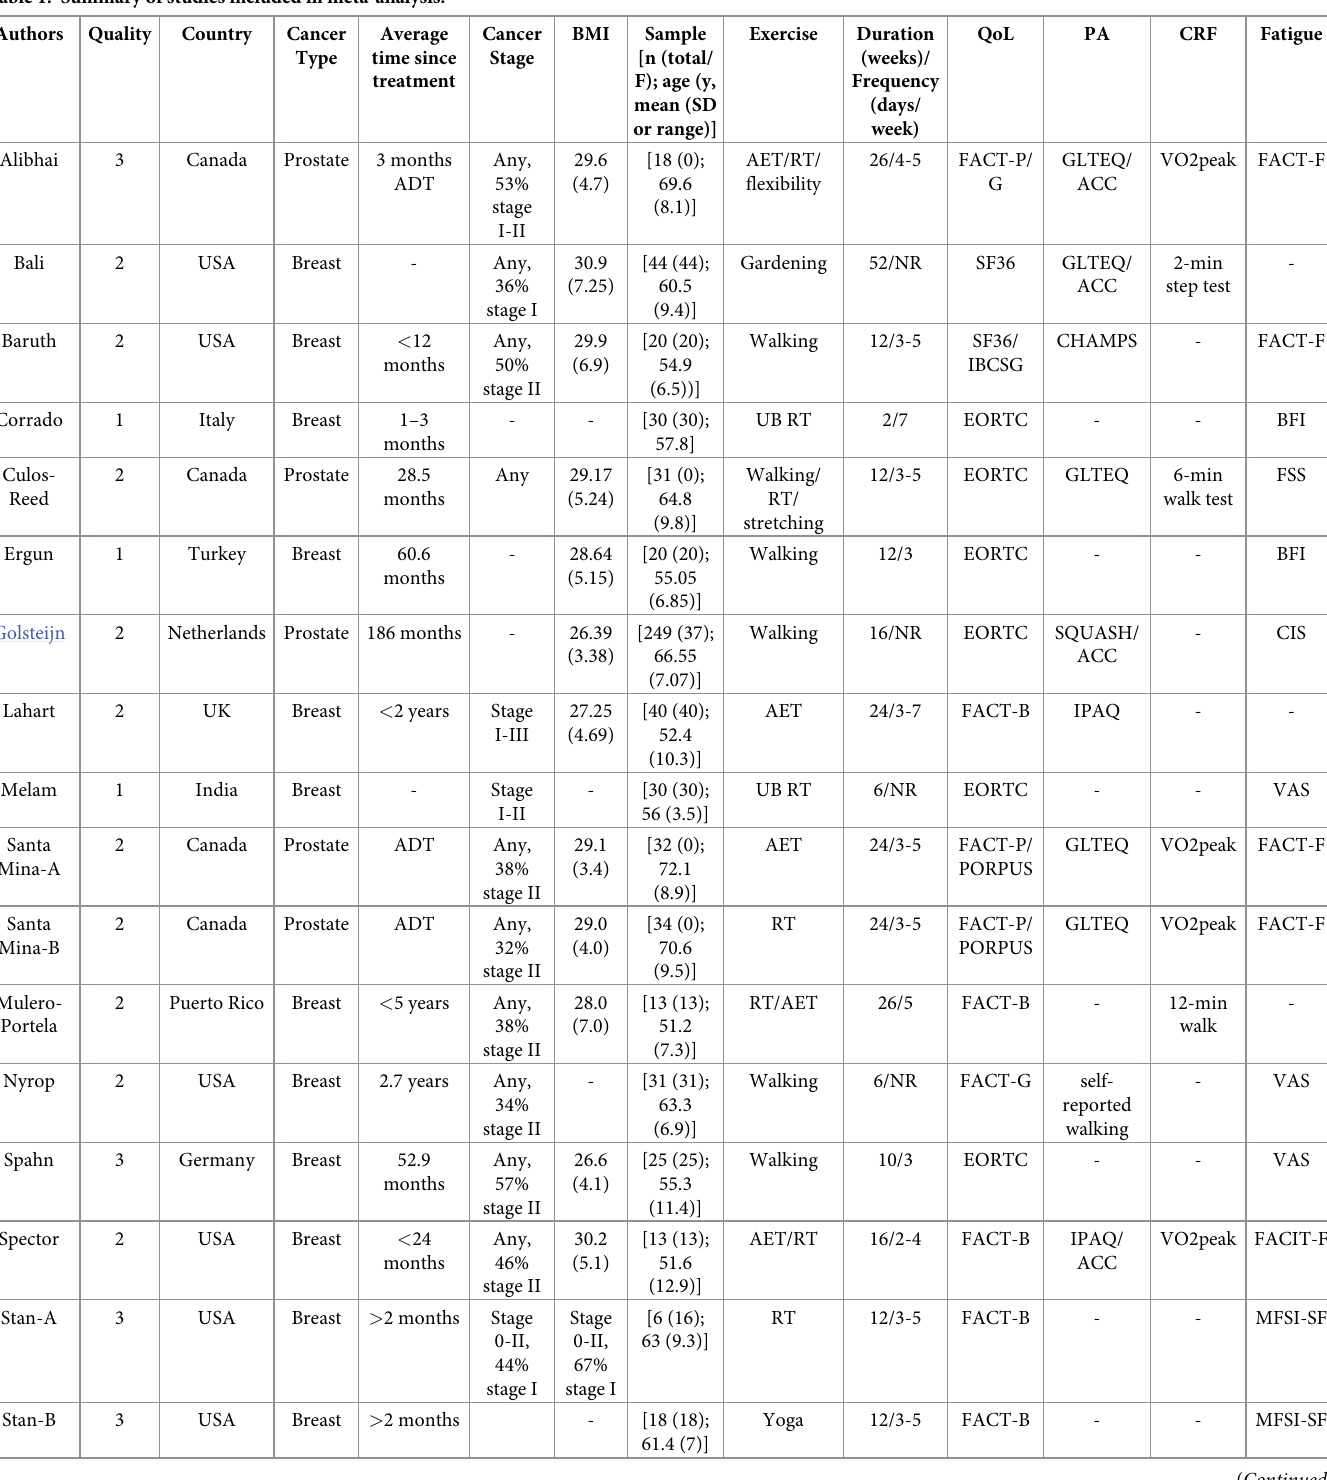
Table 1. Summary of studies included in